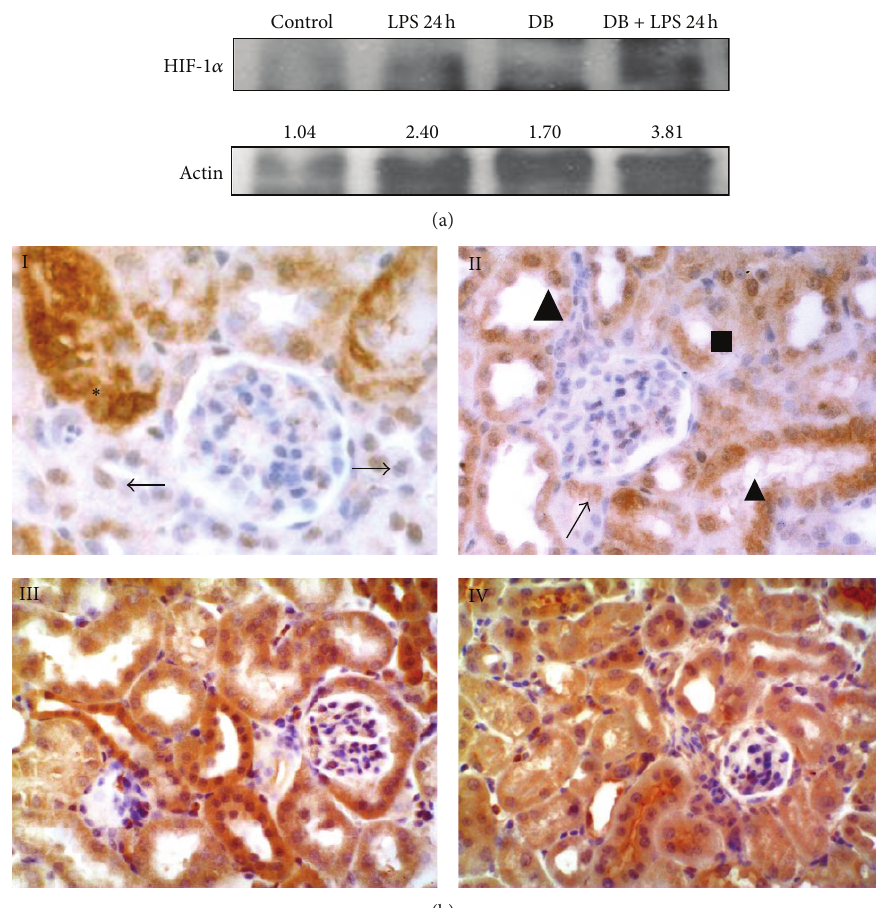
Figure 5: (a) Western-blotting analysis of HIF-1 𝛼 in renal tissue. Quantification of HIF-1 𝛼 signal normalized by 𝛽 -actin signal is also shown. (b) HIF-1 𝛼 immunohistochemistry. I: control kidney. An intense immunoexpression of HIF-1 𝛼 was detected in the cytoplasm of proximal convoluted tubules ( ∗ ), and in the nuclei of distal tubules, the labelling was weaker ( → ). II: diabetic mice. Proximal tubules showed positive reaction to HIF-1 𝛼 in the cytoplasm ( ◼ ). Both nucleus and cytoplasm of distal convoluted tubules cells ( 󳵳 ) presented a positive reaction to HIF-1 𝛼 . The arrow points to the urinary pole with moderate reaction to this antibody. III: LPS-treated mice. Both convoluted tubules showed a strong immunolabelling to HIF-1 𝛼 . IV: diabetic LPS-treated mice. The highest reaction to HIF-1 𝛼 was encountered in the kidney of diabetic mice treated with endotoxin. Magnification: I and II: × 600; III and IV: ×